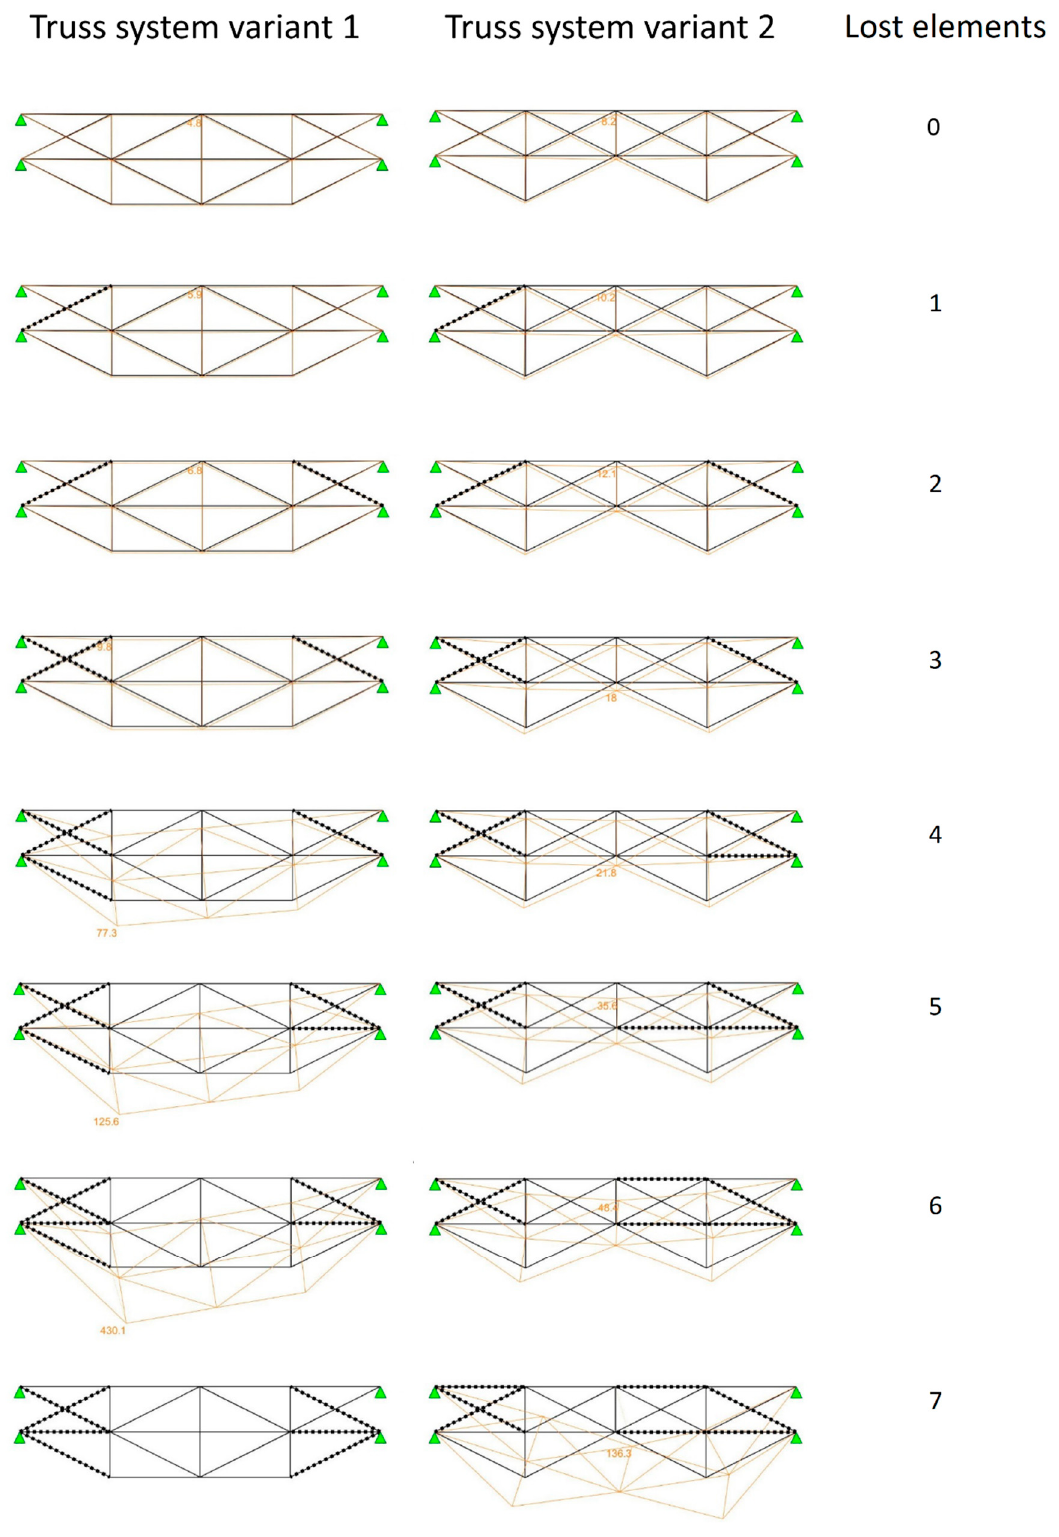
Figure 5. Deformation patterns of the investigated systems at sequences of component losses. The member with the highest degree of utilization fails first. After redistribution of the loads, the next member exposed to the highest stress fails. This process is continued until the systems can